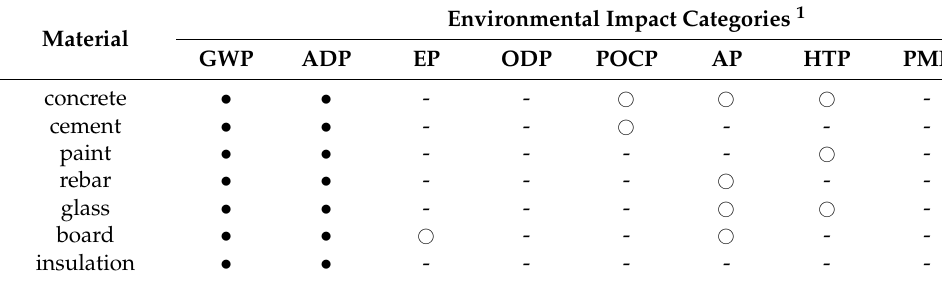
Table 7. Deduction of the major environmental impact